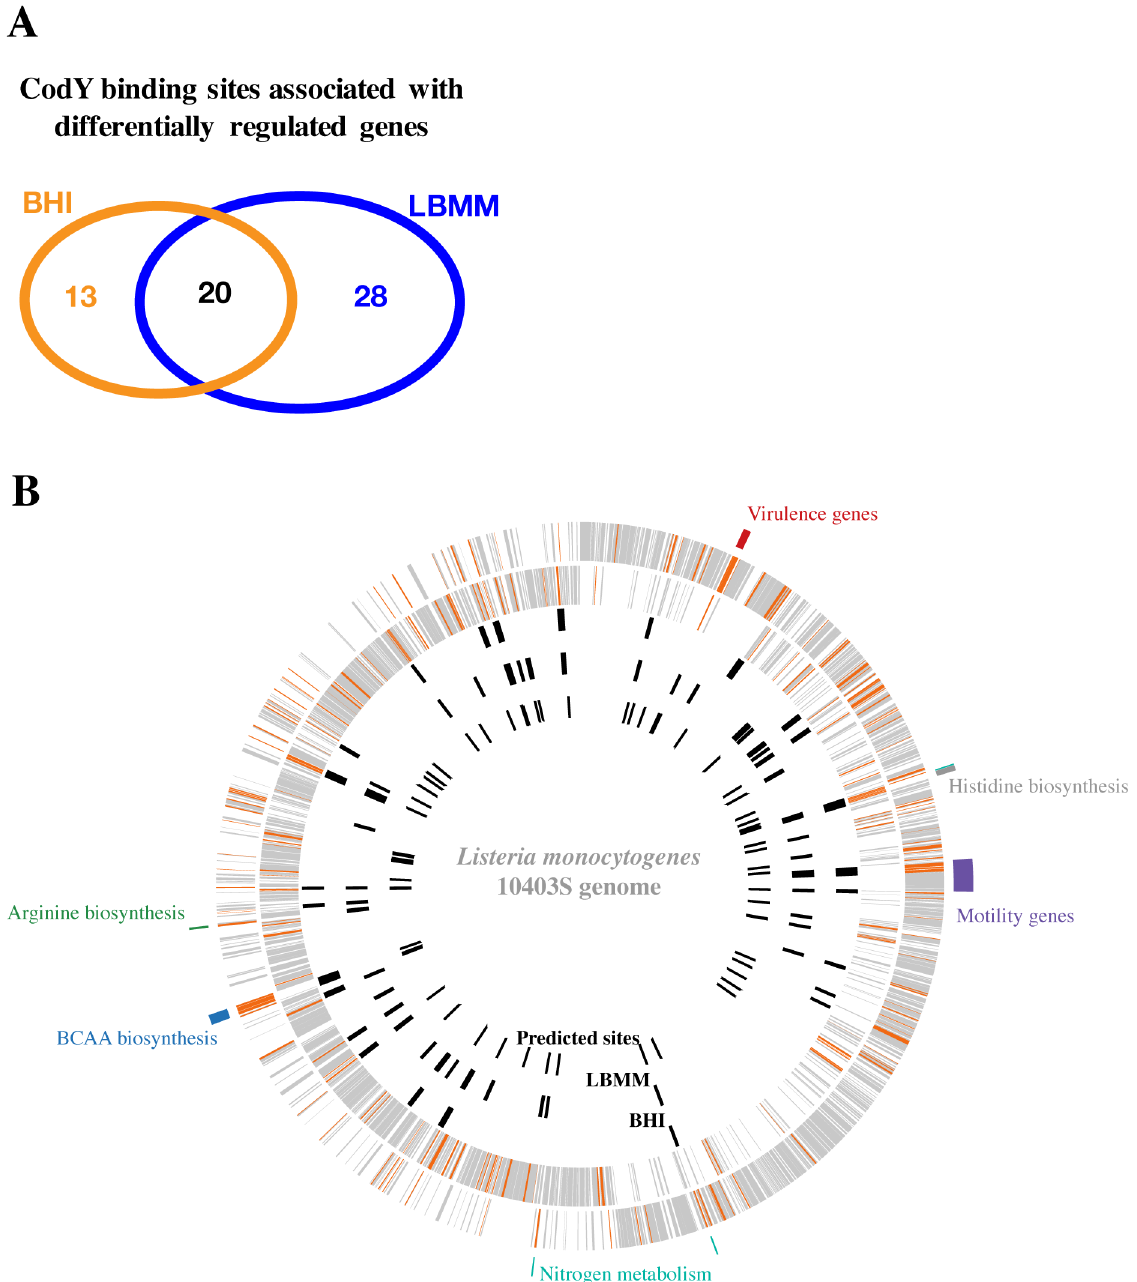
Fig 3. ChIP-seq analysis of CodY binding sites under growth in BHI and LBMM media. A. Venn diagram representing CodY binding sites associated with differentially expressed genes in BHI and LBMM. B. Genomic view of CodY binding sites in L . monocytogenes 10403S – the two outer circles represent the + and — strands of L . monocytogenes genome, each line is a gene. Orange lines represent CodY regulated genes, while grey lines represent genes unaffected by CodY (based on the RNA-Seq analysis). The third circle represents CodY binding sites associated with differentially expressed genes in BHI medium, while the forth circle represents CodY binding sites associated with differentially expressed genes in LBMM. The fifth circle represents CodY motifs associated with differentially expressed genes, identified by the MAST algorithm [46] using a CodY binding consensus sequence as an input based on previous experimental CodY-box analyses [36, 37]. The consensus sequence was generated using the MEME algorithm [47]. Only sites with E value < 10 and P value < 0.05 are shown.